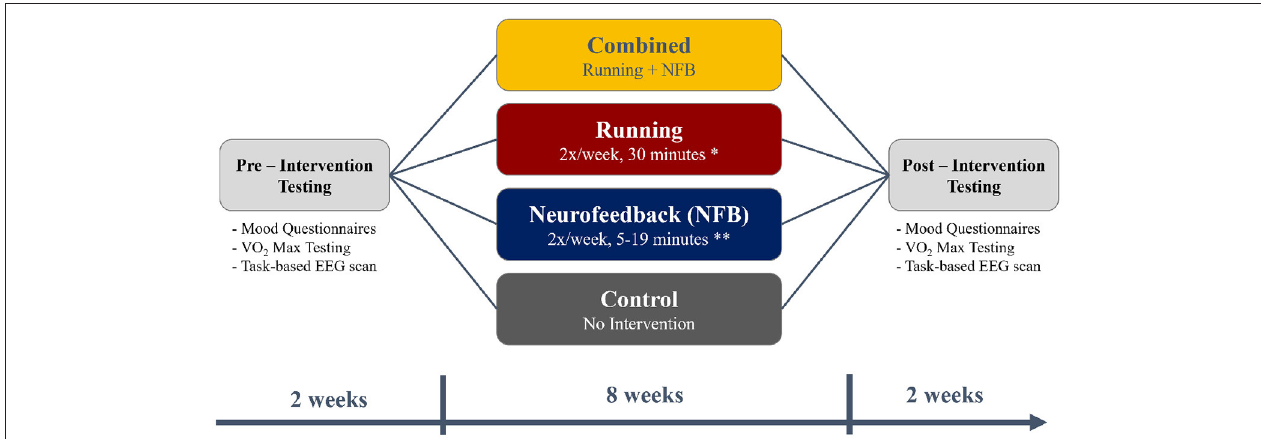
FIGURE 1 | A flowchart depicting the timing of the pre-intervention testing (2 weeks), the intervention (8 weeks), and post-intervention testing (2 weeks). The timings were chosen to fit within the first 3 months of the 4-month long university